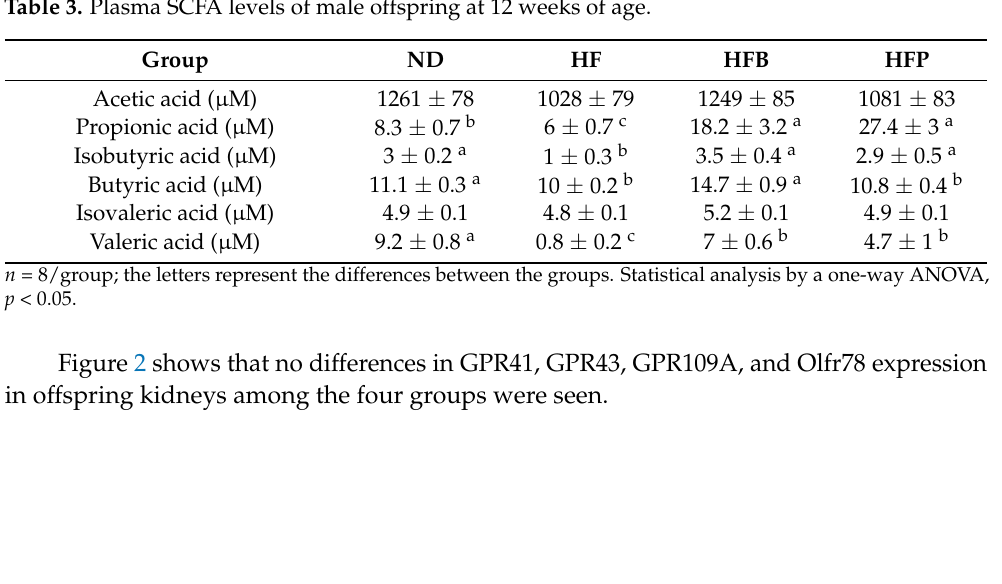
di ff erences between the groups. Statistical analysis by a one-way ANOVA, p < 0.05. differences between the groups. Statistical analysis by a one-way ANOVA, p < 0.05.